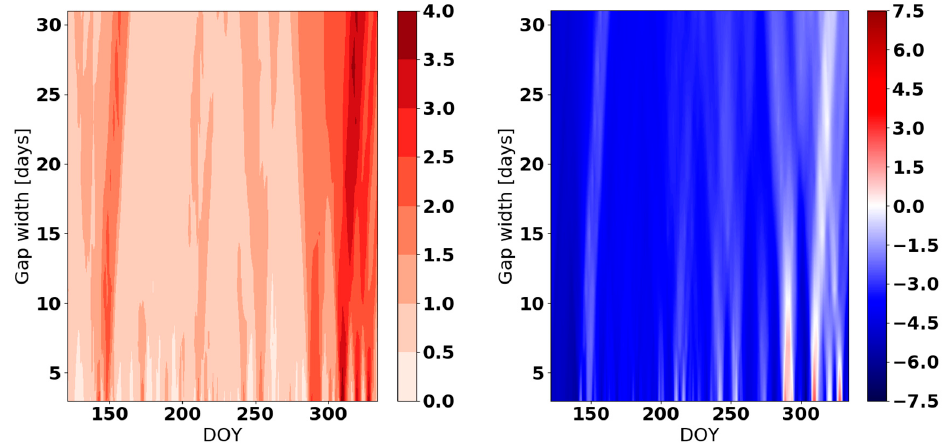
Figure A7. RMSE DEB (left panel ) and (RMSE DEB -RMSE ERA5 ) difference ( right panel ) calculated using daily data for DOY 121–334 2017 in Gumpenstein.